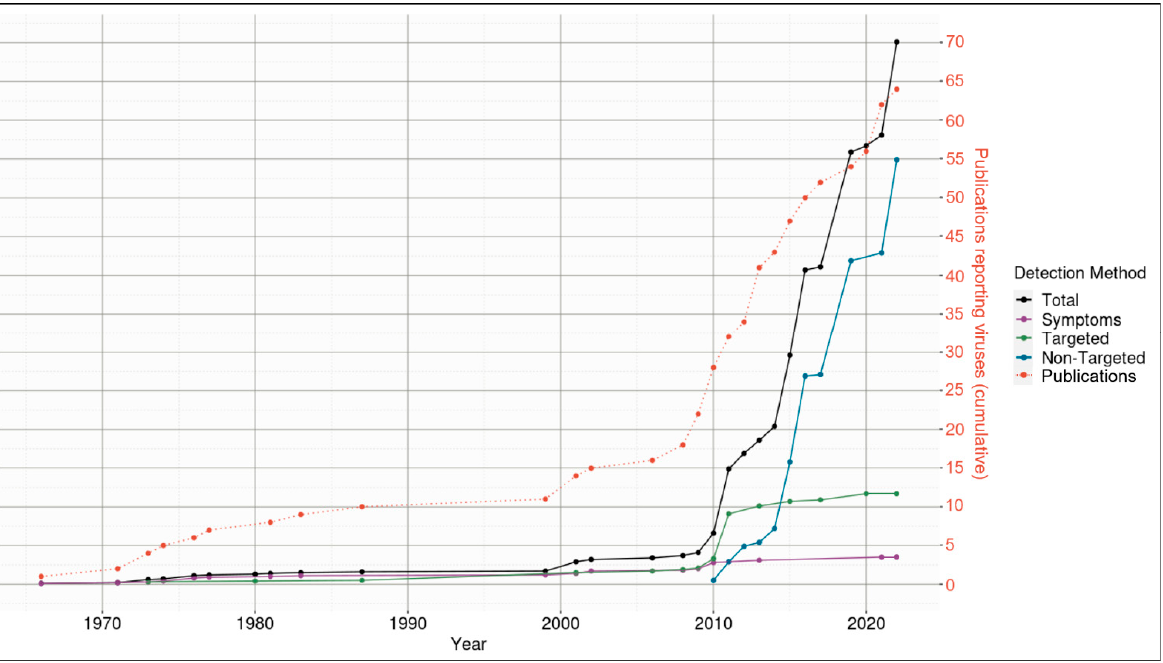
Figure 1. The cumulative viruses reported across time from 1966 to February 2022, with a specific focus on the detection method used for identification, and the number of publications in Aotearoa New Zealand indigenous hosts. ‘Total’ refers to all viruses discovered in Aotearoa New Zealand, independent of detection method. ‘Symptoms’ refers to viruses detected with symptom observation. ‘Targeted’ refers to viruses identified via targeted approaches for known viruses. ‘Non-targeted’ refers to broad-spectrum viral identification. The secondary axis in orange ‘Publications reporting viruses (cumulative)’, associated with the dotted line, refers to the number of publications reporting the viruses.